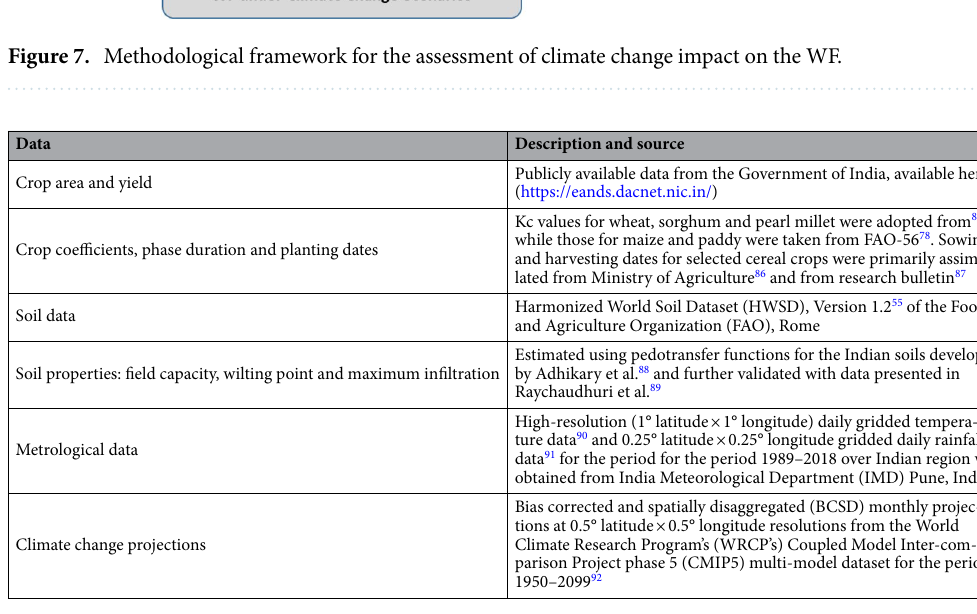
Table 2. Datasets used in the